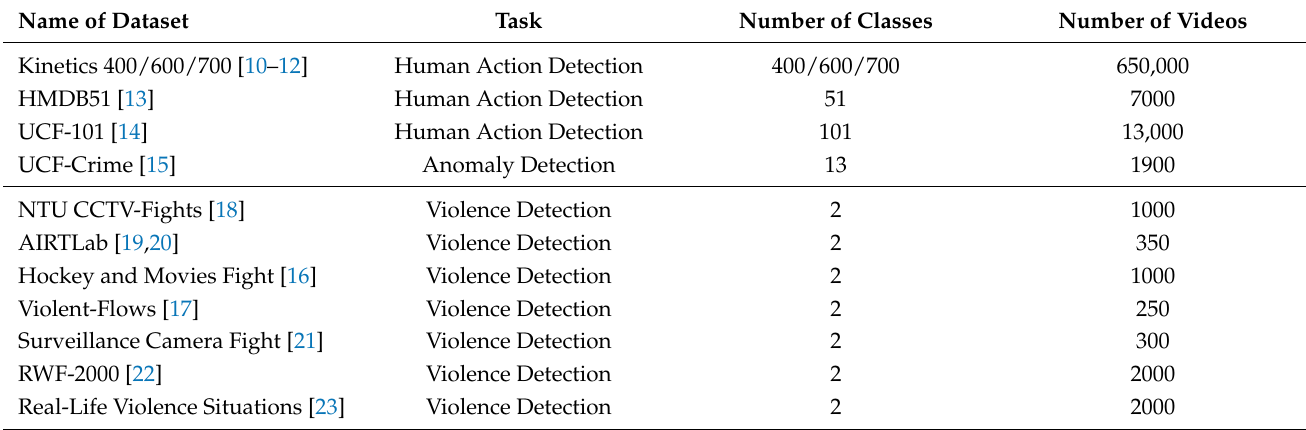
Table 1. Summary of the most popular existing datasets in the literature. We report the task for which they are used, together with the number of classes and videos that characterized